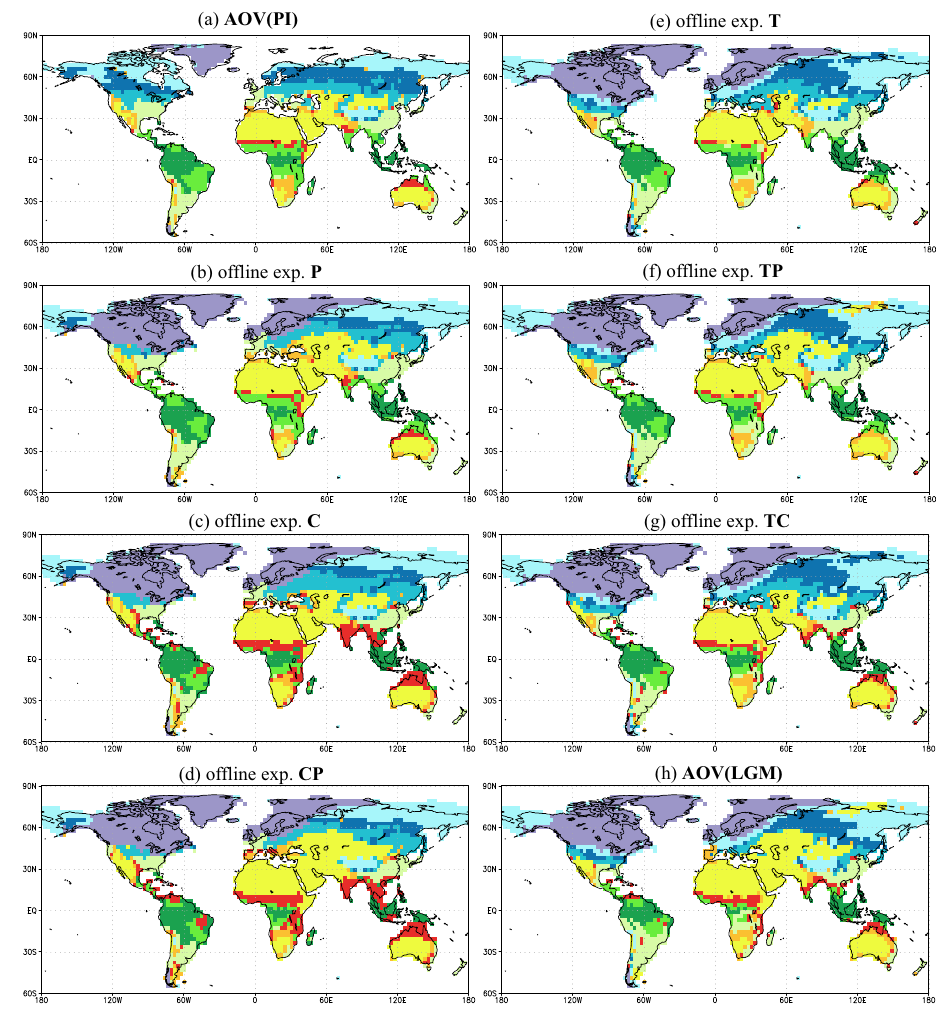
Fig. 2. Vegetation distribution obtained in (a) AOV(PI) and (h) AOV(LGM) (they are as same as Fig. 1 and shown again for convenience). Vegetation distribution obtained in offline sensitivity experiments (b) P , (c) C , (d) CP, (e) T , (f) TP and (g) TC according to MATSIRO